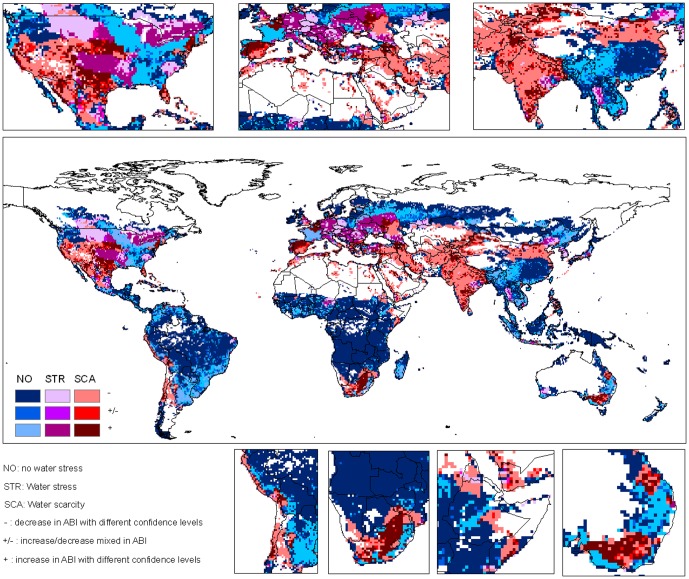
Change of irrigation water proportion in the 2090s in relation to water scarcity.Water scarcity is defined for the regions where total water withdrawal exceeds 40% of the freshwater resources, while water stress is defined for the regions where total water withdrawal is 20%–40% of the freshwater resources. ABI indicates irrigation water proportion.